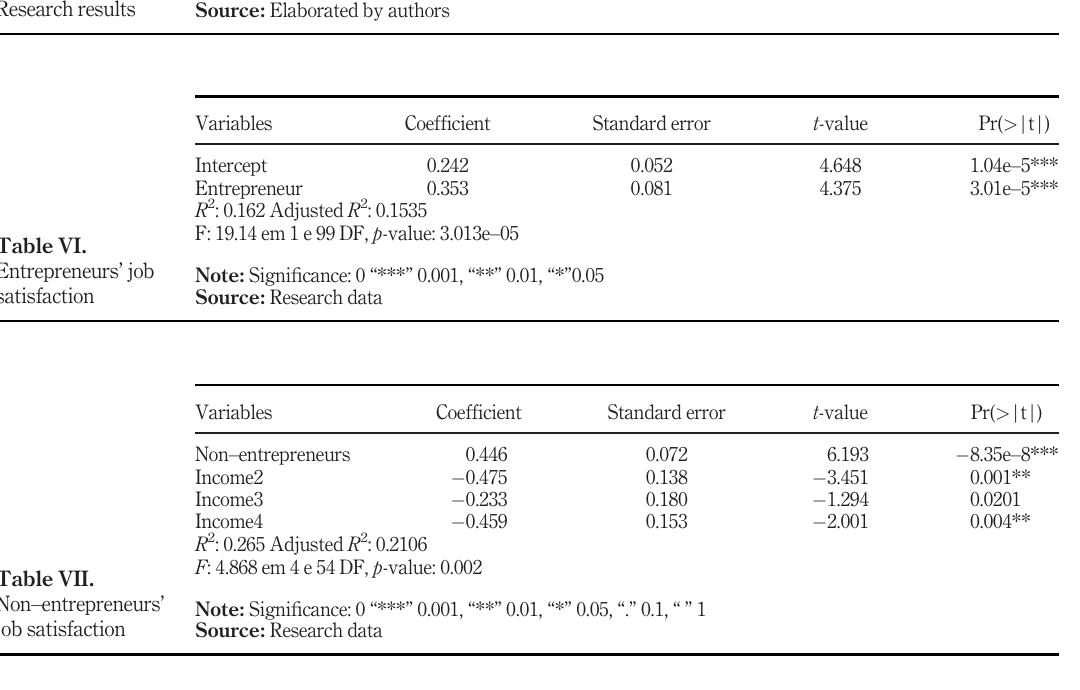
Table V. Research results